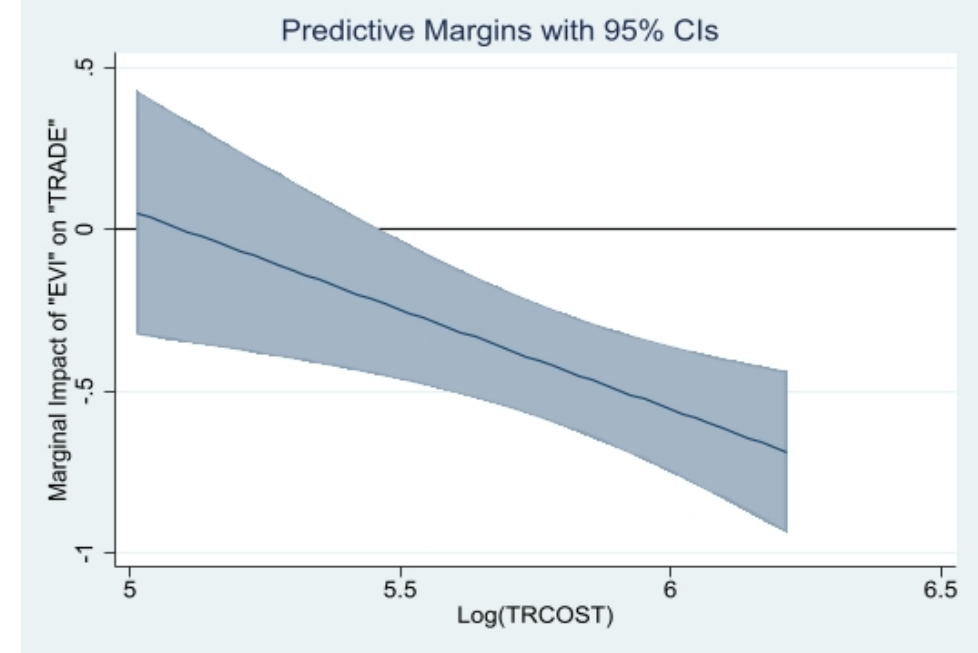
Figure 9. Marginal impact of “EVI” on “TRADE” for varying levels of trade costs. Source: Author.